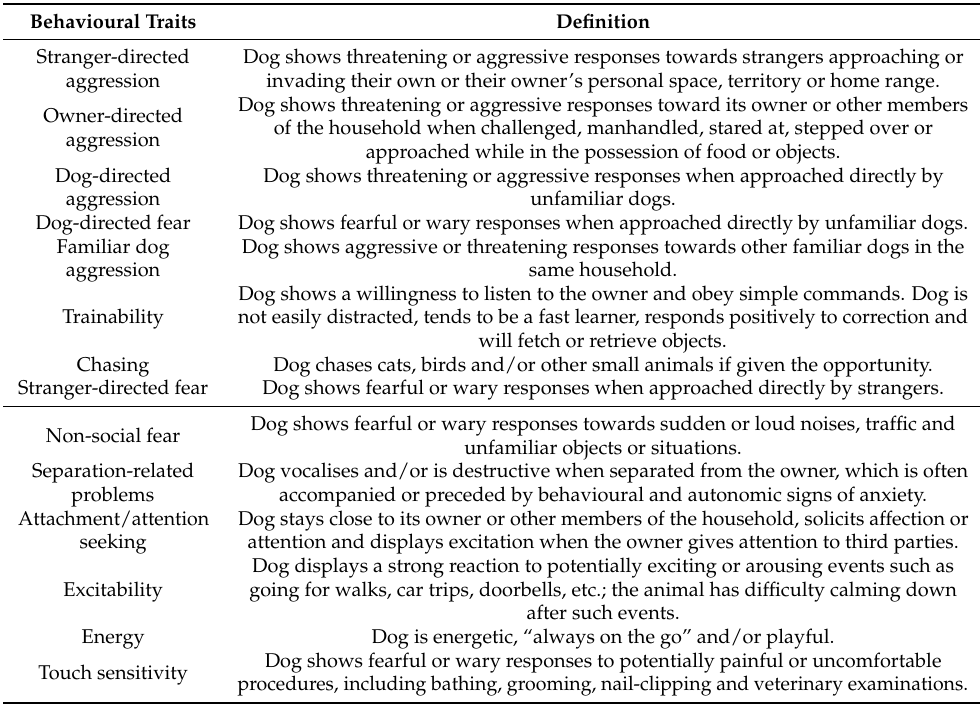
Table A1. Behavioural traits included in the Canine Behavioural Assessment and Research Question- naire, including their definitions.